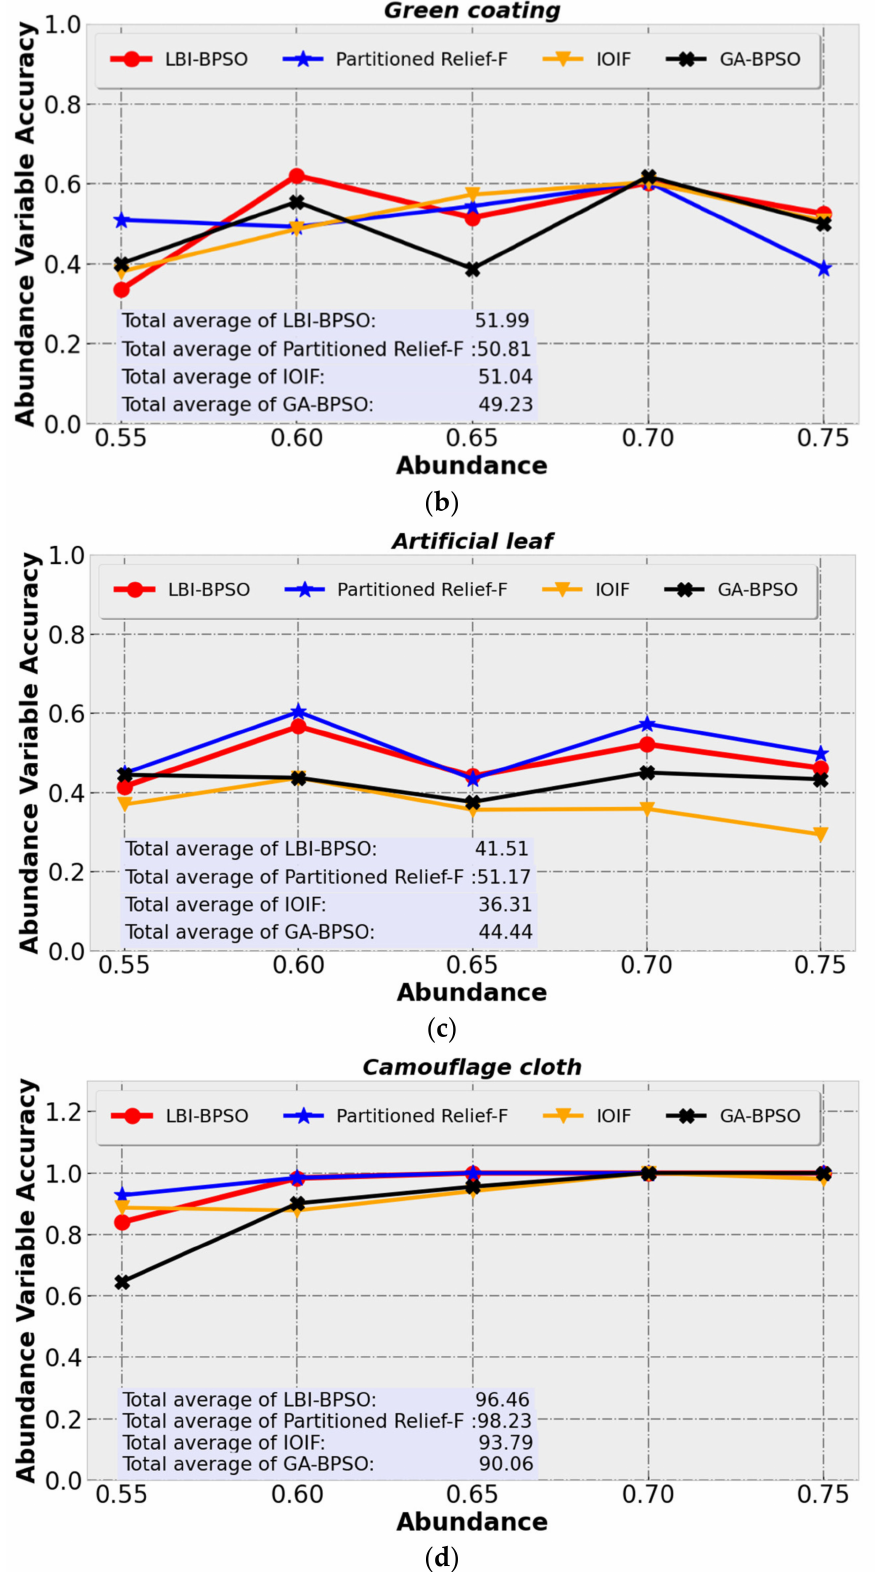
Figure 12. Evaluation of classification results under different abundances (SNR = 1000). ( a ) Vegetation; ( b ) Green coating; ( c ) Artificial leaves; ( d ) Camouflage